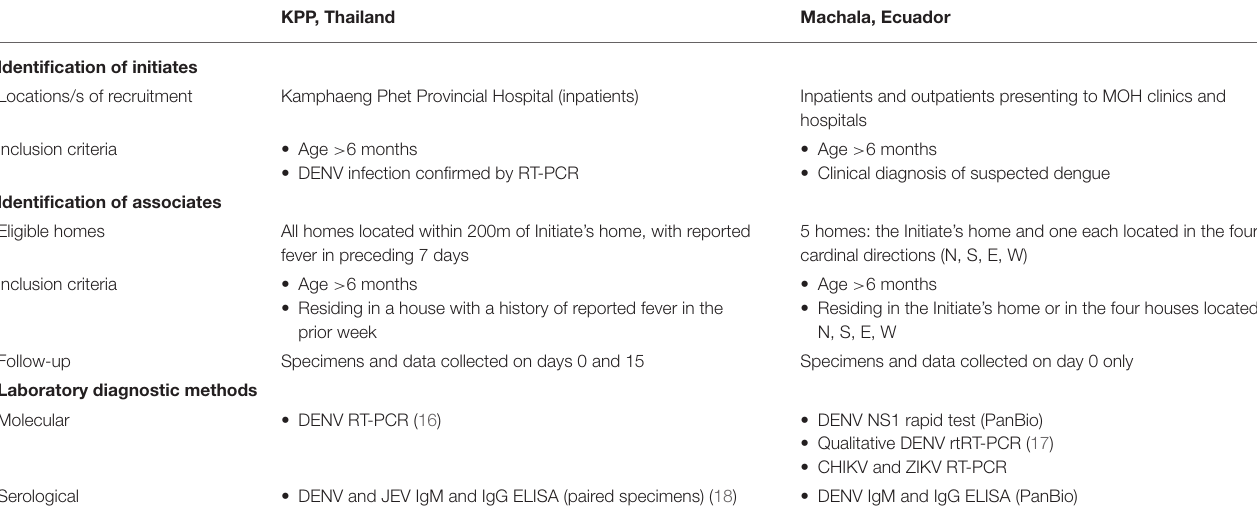
TABLE 1 | Study-specific methods in KPP, Thailand, and Machala,